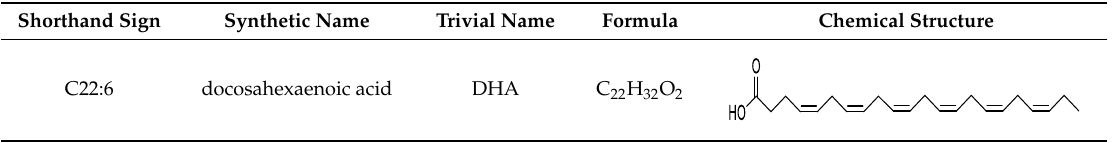
Table 1. The chemical structure and formula of the DHA molecule.